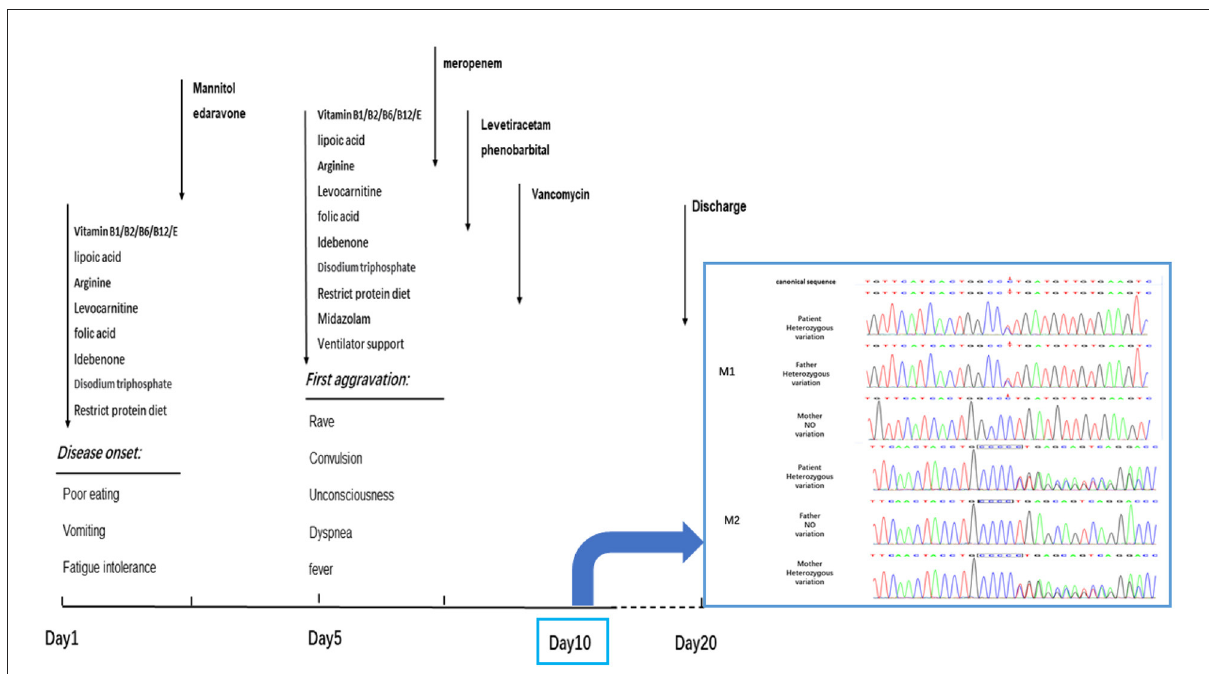
FIGURE2 The progress of disease and the timeslot for the medical intervention. The patient got worsen on the 5th day during the hospitalization and then recovered slightly. Dark arrows represented the drug treatment. On the 10th day, the clinical exon sequencing (CES) showed one heterozygous missense mutation and one heterozygous frameshift mutation were detected by CES. M1, missense mutation; C.683C > T: P. Pro228Leu. M2, frameshift mutation; C.838–839insC: P. Leu280fsTer11. The results of Sanger sequencing revealed that the M1 mutations was inherited from her father, and M2 mutations from her mother. The patient was discharged on the 20th day without improving